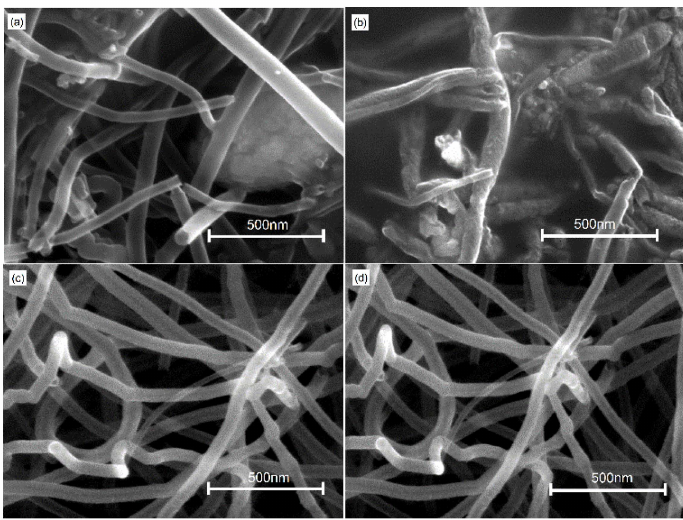
Figure 2. SEM images of crossed MWCNTs after 1064 nm laser irradiation on different substrates: ( a ) 3 s, silica; ( b ) 6 s, silica; ( c ) 6 s, silicon; and ( d ) 8 s, silicon.